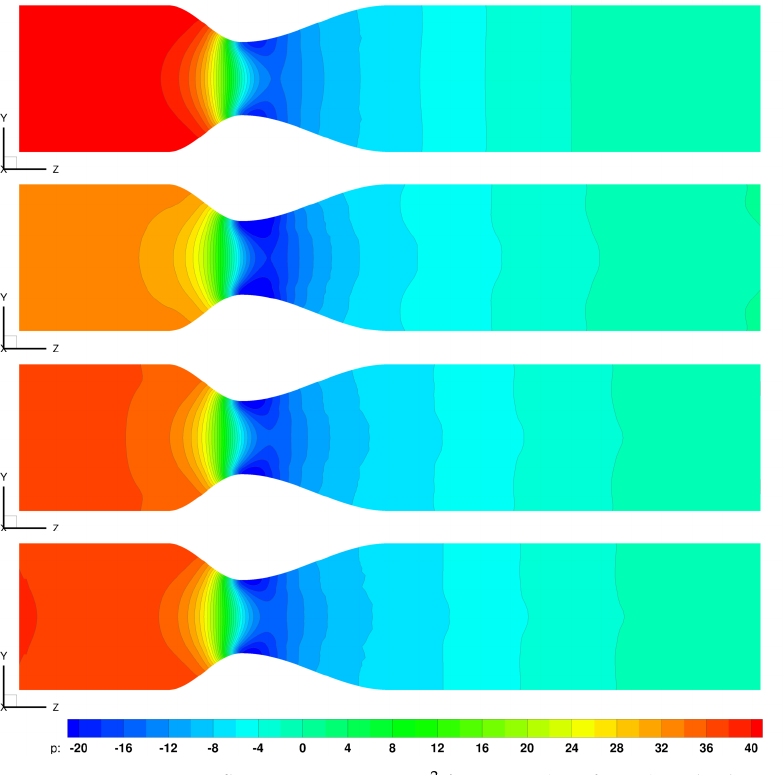
Figure 23. Pressure at flow rate Q = 2.0 cm 3 / — GOB (top figure) and Johnson–Segalman models for a = − 0.9, a = − 0.8, a = − 0.7 (from the